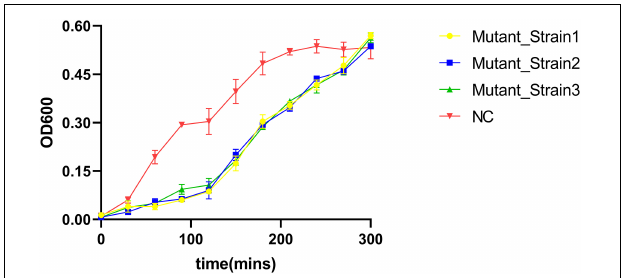
FIGURE 3 | V. alginolyticus kill curve. V. alginolyticus was incubated with/without the addition of the phage, and the curve was plotted by measuring V. alginolyticus OD600 at 30-min